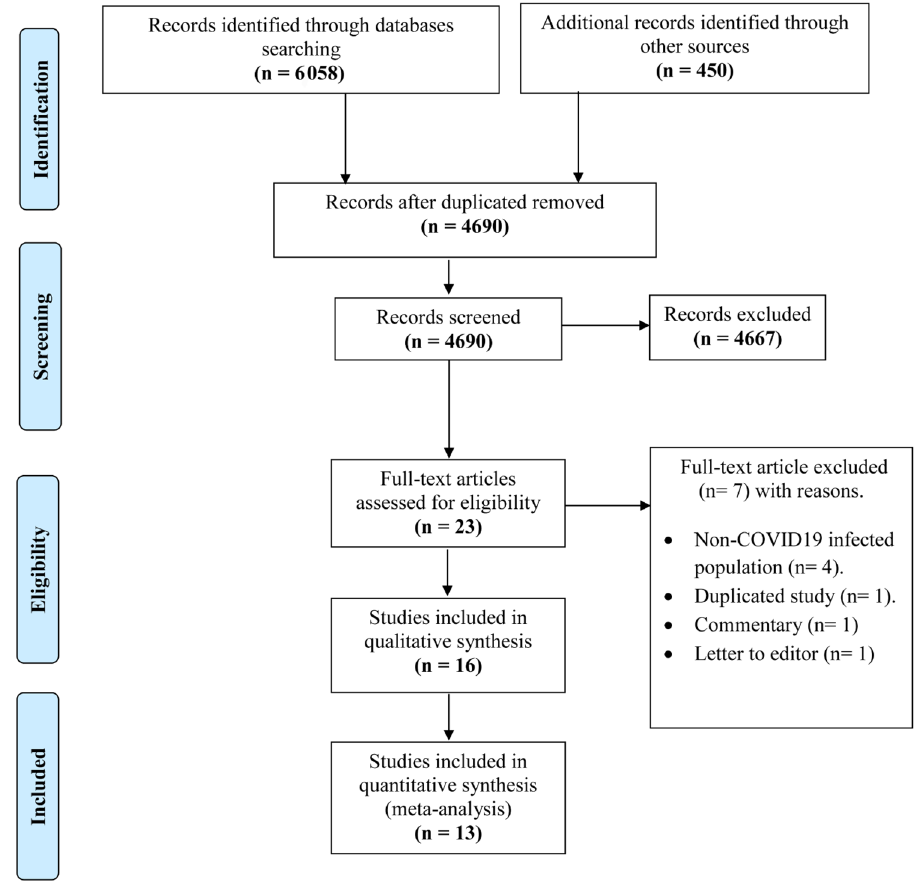
Figure 1. PRISMA flow chart which summarizes the literature search, and included